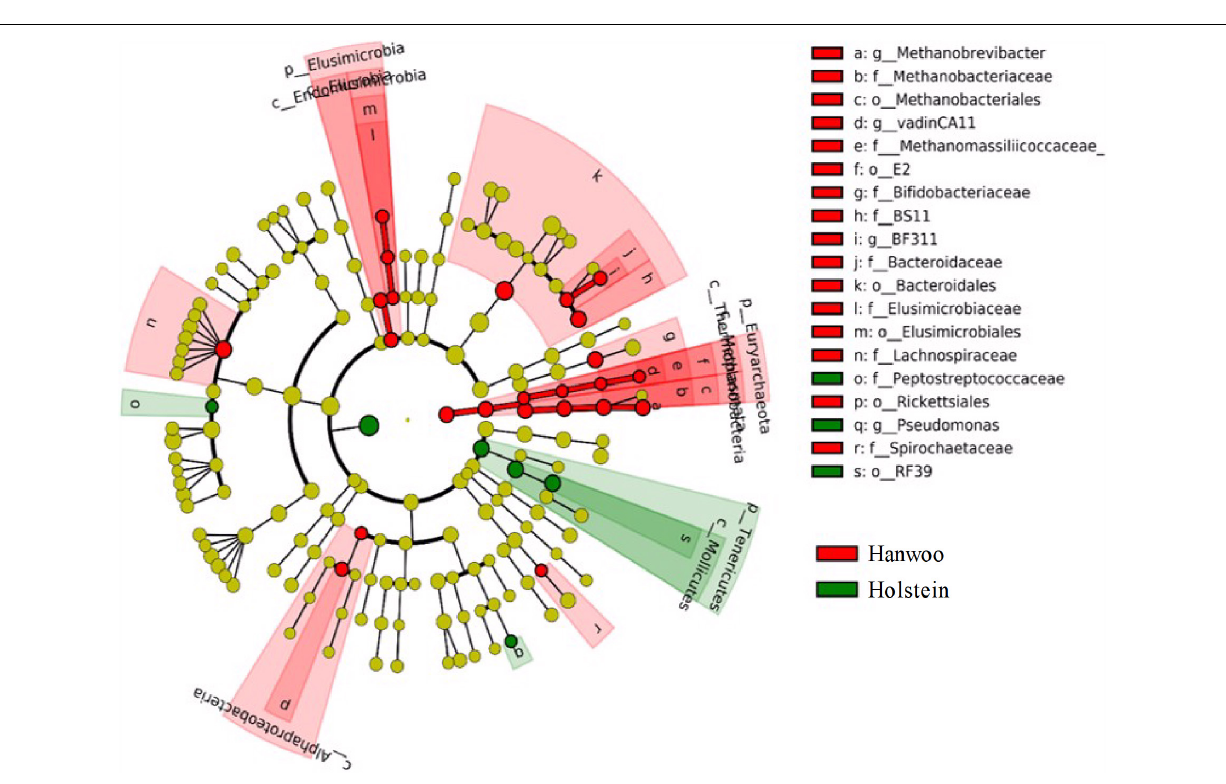
FIGURE 3 | LDA effect size (LEfSe) cladogram demonstrating taxonomic differences between the Hanwoo and Holstein breeds. Taxa enriched in the rumen of Holstein steers are indicated by a positive LDA score (green), while taxa enriched in the rumen of Hanwoo steers have a negative score (red). Only taxa meeting an LDA significance threshold of 2 and P < 0.05 are